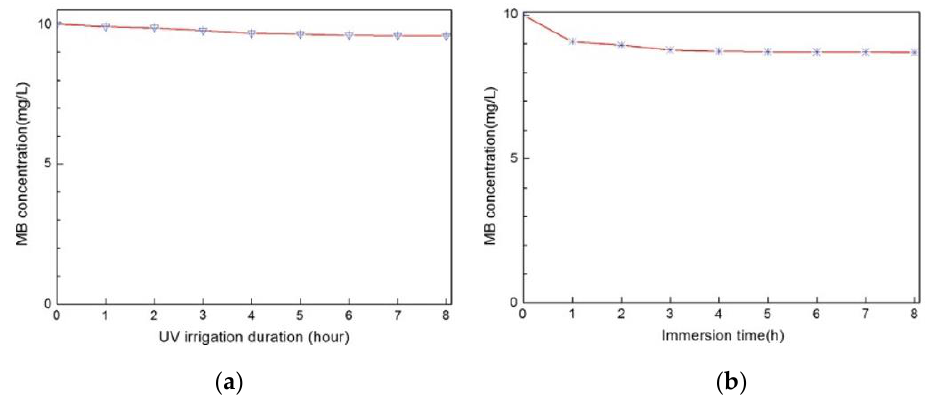
Figure 4. The methylene blue (MB) colour change under UV light ( a ) without photocatalyst precursor; ( b ) with photocatalyst precursor [120].